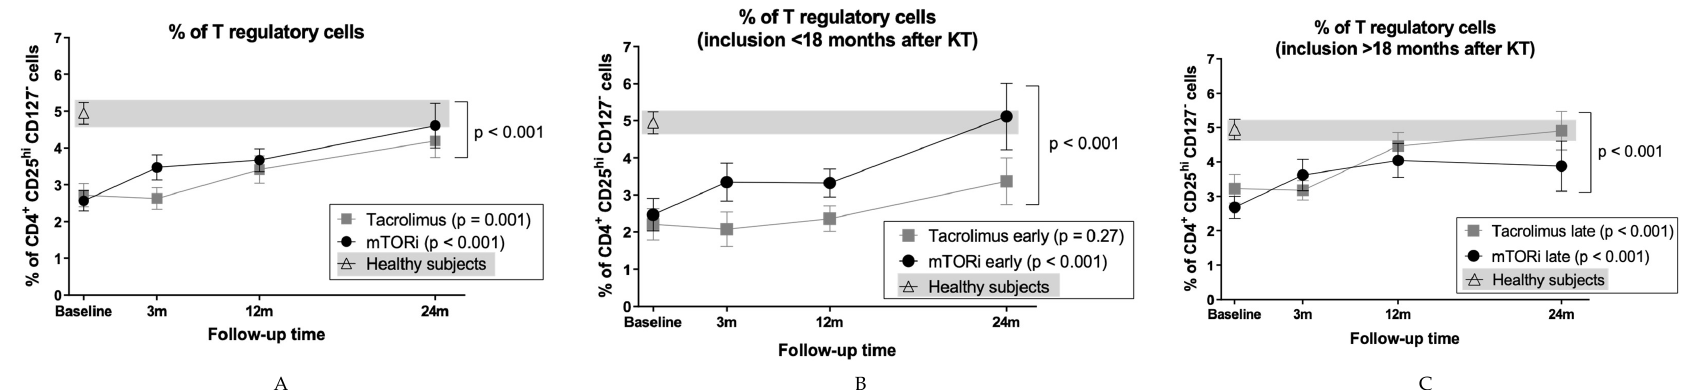
Figure 2. Evolution of Tregs after switching from tacrolimus to mTORi in all cases and according to time of inclusion in the study. Immunophenotyping of ( A ) total Tregs, ( B ) Tregs in patients included in the study during the first 18 months after transplantation, and ( C ) Tregs in patients included in the study after 18 months posttransplant. Patients before and after switching to mTORi are depicted with black dots, and patients maintaining tacrolimus are depicted with grey squares. HS data is depicted with white triangles, and the grey background corresponds to range. Plots show mean and SEM for each time point.